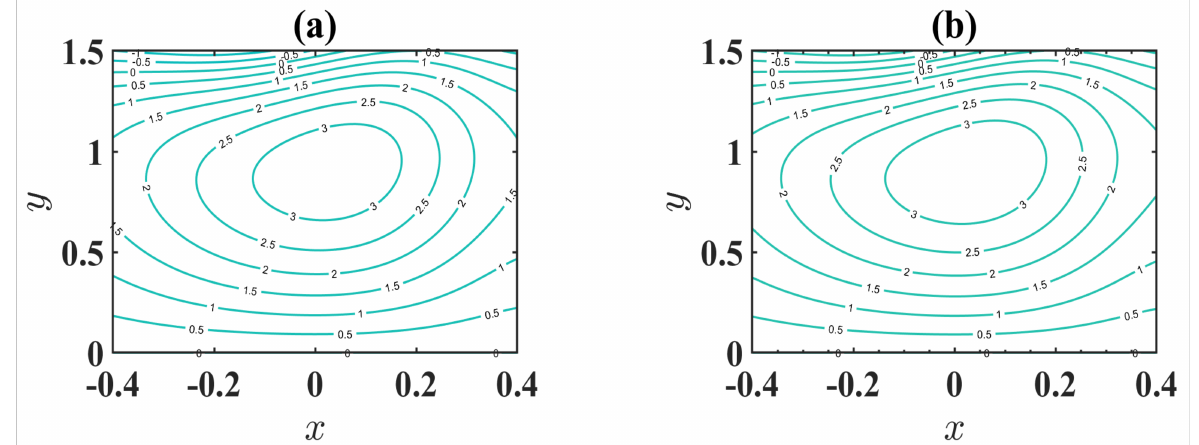
Figure 10. Streamline for varying ( a ) α 1 = 0 and ( b ) α 1 = 0.02.